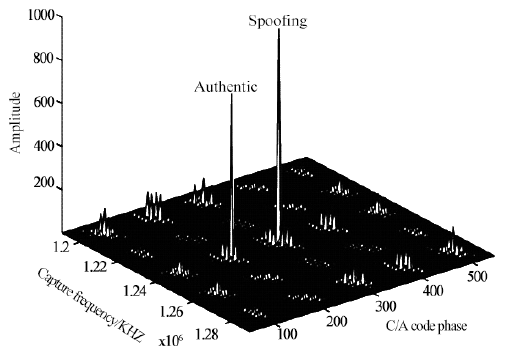
Figure 7. Spoofing attack in capture stage.